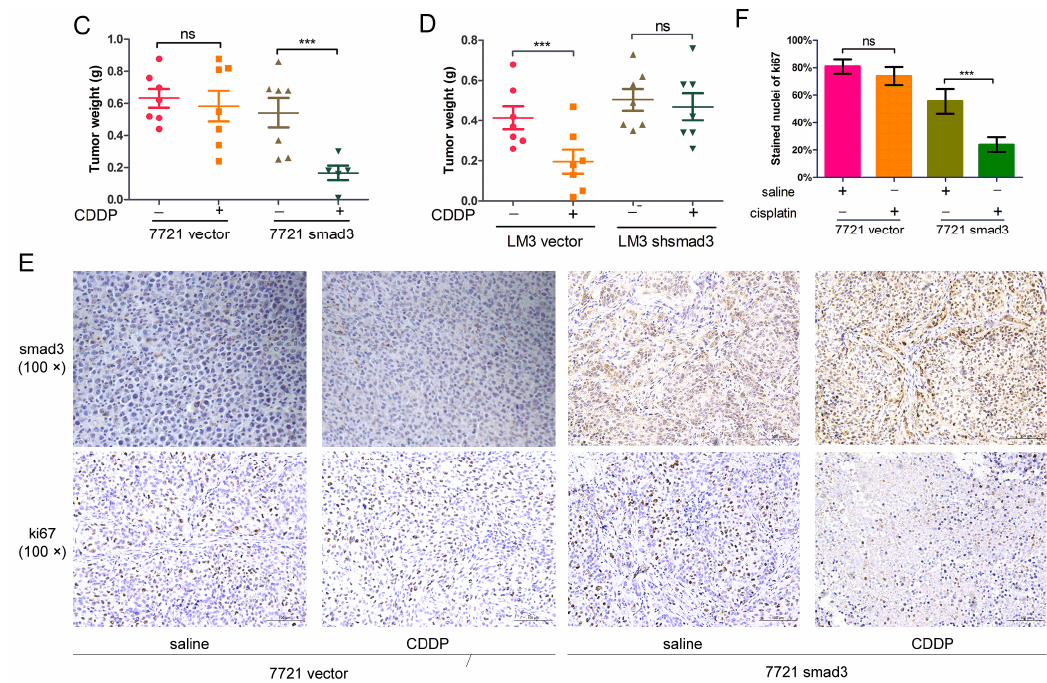
Figure 3. Smad3 increases the sensitivity of HCC to cisplatin in vivo . SMMC-7721 ( A ) and HCC-LM3 ( B ) cells were injected subcutaneously into Balb/c-nu mice and cisplatin was injected i.p. every three days; ( C , D ) Tumor weight was examined after mice were sacrificed; ( E ) Subcutaneous tumors were subjected to smad3 and ki67 staining. Representative pictures are shown (100×); ( F ) The percentage of ki67 stained nuclei was calculated in different groups. All the results are represented as the mean ± S.D. from three independent trials. ( *** p < 0.001; n.s. means no significance).